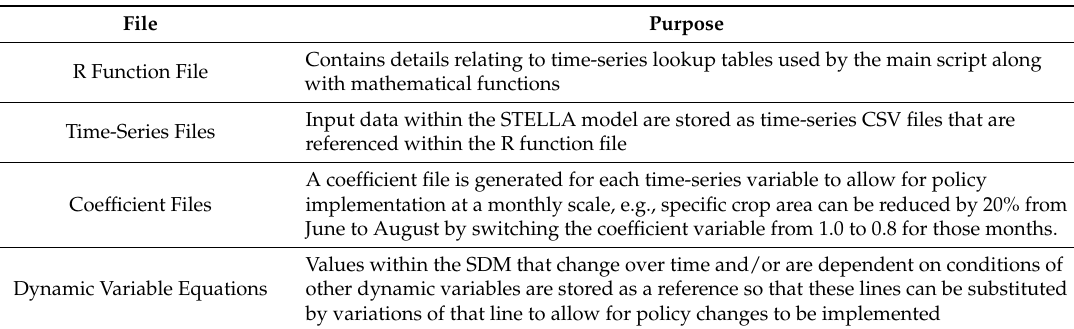
Table 1. Data outputs from STELLA conversion to